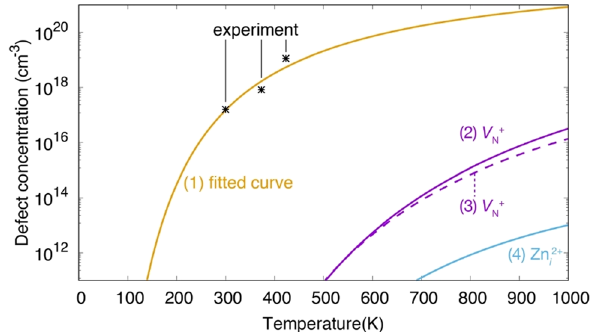
Figure 3: Temperature dependence of defect concentrations in Zn 3 N 2 . Curve ( 1 ) shows the concentrations of + O N , + H i or both of them fi tted to the experimental n fi lms grown at near 300 K of Zn 3 N 2 thin room temperature. Curves ( 2 ) and ( 3 ) represent the concentrations of + V N calculated by using the formation free energies depending on the temperature and the formation energies of the competing Figure 4: Carrier concentration as a function of cation composition phases at 0 K, respectively. Same data as ( 2 ) but for + Zn i 2 is shown Zn/ ( Zn + Sn ) in ZTN thin fi lms deposited at various temperatures ( near room temperature, 250 and 350°C ) ( reprinted from ref. [ 28 ]) as curve ( 4 ) ( reprinted from ref. [ 31 ]) .